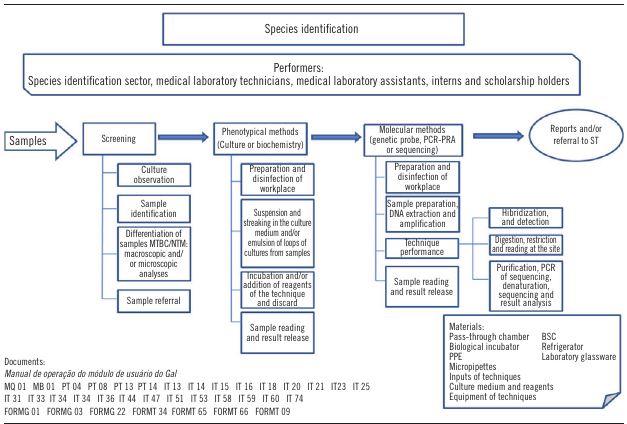
figurE 6 – Flow chart of MTB and NTM species identification assay PCR-PRA: polymerase chain reaction-pattern restriction analysis; ST: sensitivity test; BSC: biological safety cabinet; PPE: personal protection equipment; MTBC: M. tuberculosis complex; NTM: non-tuberculous mycobacteria.